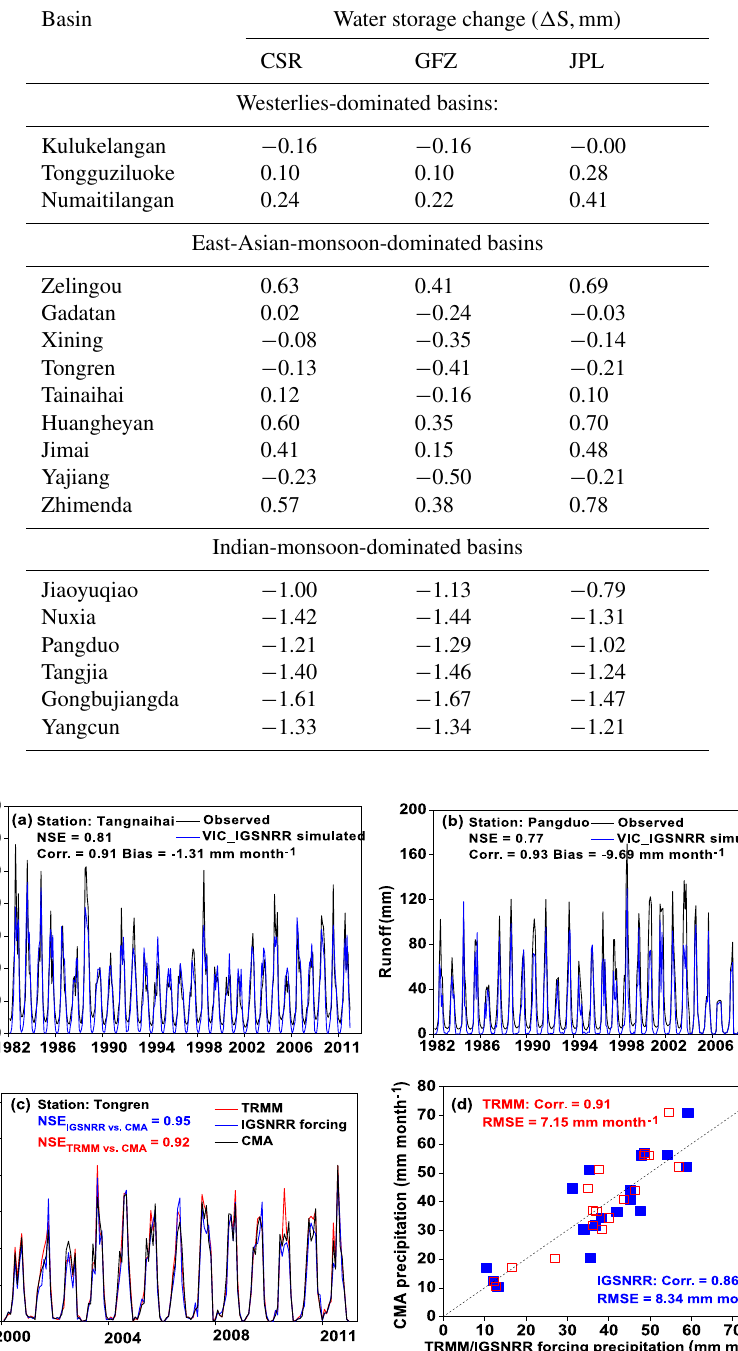
Figure 2. Comparison of VIC_IGSNRR-simulated and observed monthly runoff for Tangnaihai and Panduo stations (a, b) as well as (c) basin-averaged monthly TRMM, CMA gridded and IGSNRR forcing precipitations for the smallest basin (Tongren station) over the period 1982–2011. Panel (d) shows the comparison of TRMM (blue) and IGSNRR forcing (red) precipitations against CMA gridded precipitation for 18 river basins over the TP during the period